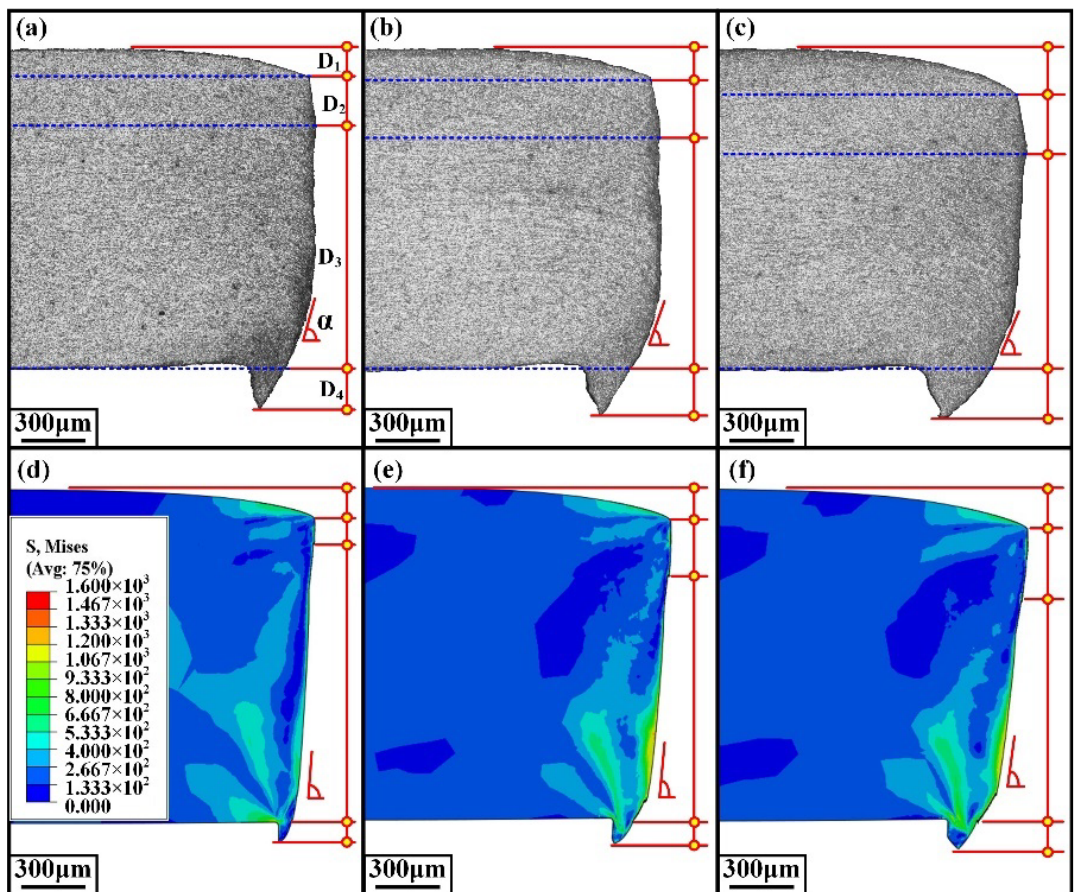
Figure 25. Experiment and simulation results of sheared edge. ( a – c ) Experiment results sheared at 5%t, 10%t, and 15%t . ( d – f ) Simulation results sheared at 5%t, 10%t, and 15%t.